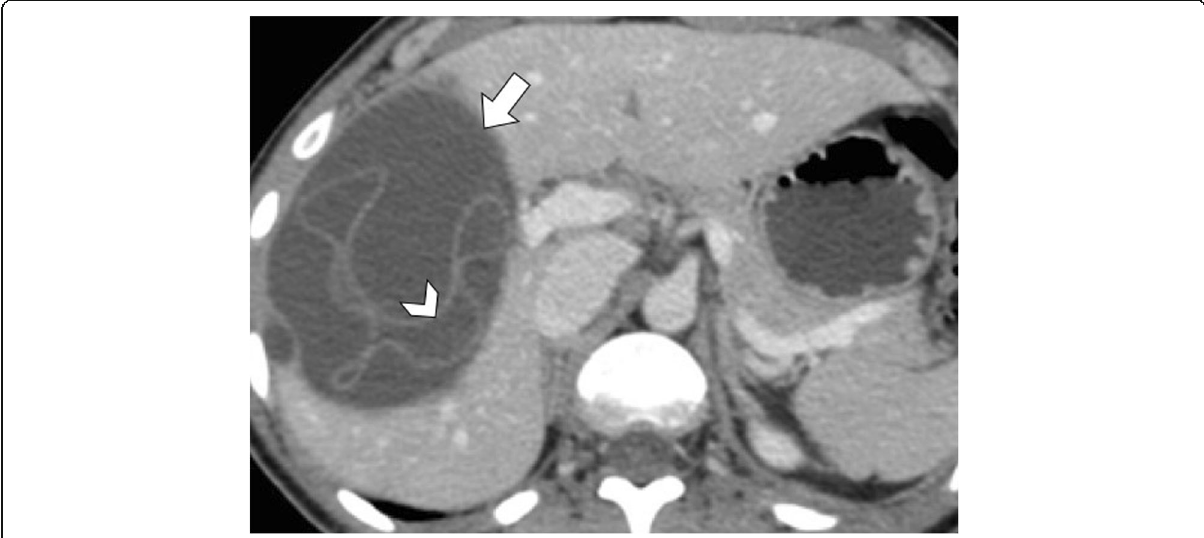
Fig. 1 A 50-year-old woman with contained rupture hydatid cyst. Axial contrast-enhanced CT on portal venous phase shows hepatic hydatid cyst (arrow) with hyperattenuating serpentine linear membrane within the cyst (arrowhead)